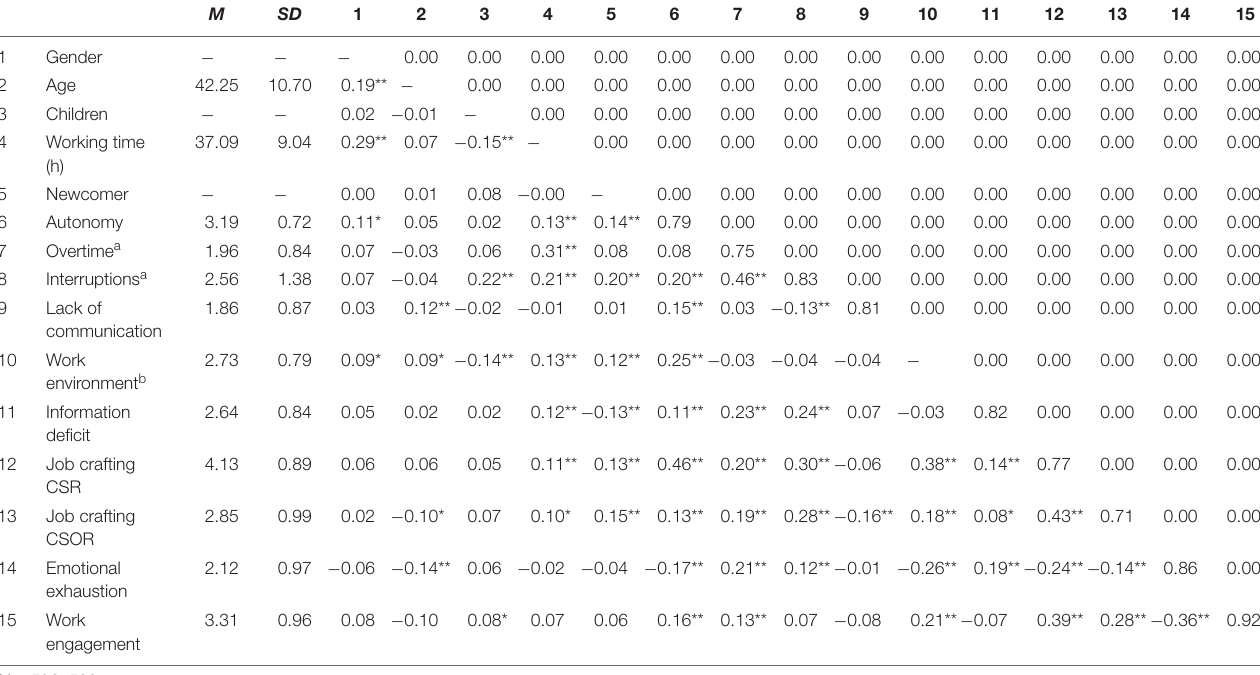
TABLE 3 | Means, standard deviations, correlations, and internal consistencies for all study